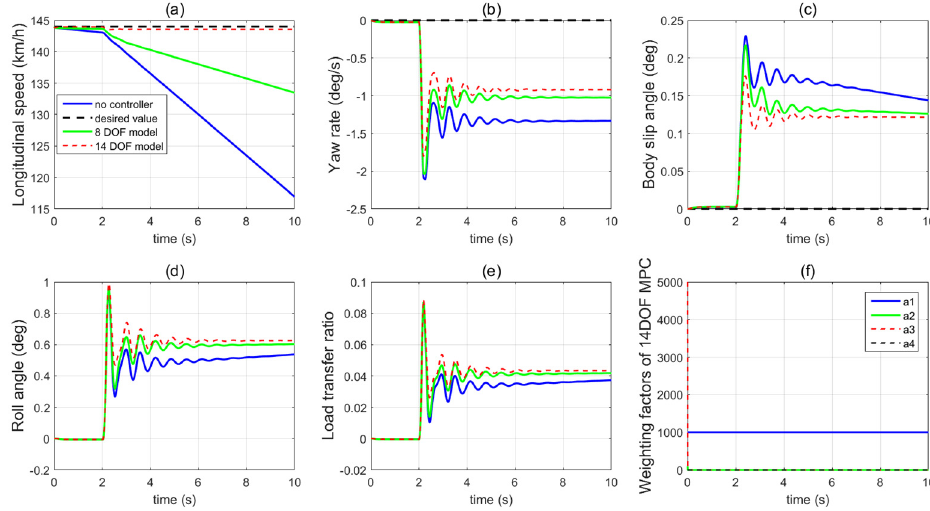
Figure 10. Vehicle dynamics performance when proposed controller applied in the first set of simulations ( a ) longitudinal velocity, ( b ) yaw rate, ( c ) body side-slip angle, ( d ) roll angle, ( e ) LTR, ( f ) scaling factors of 14 DOF MPC.